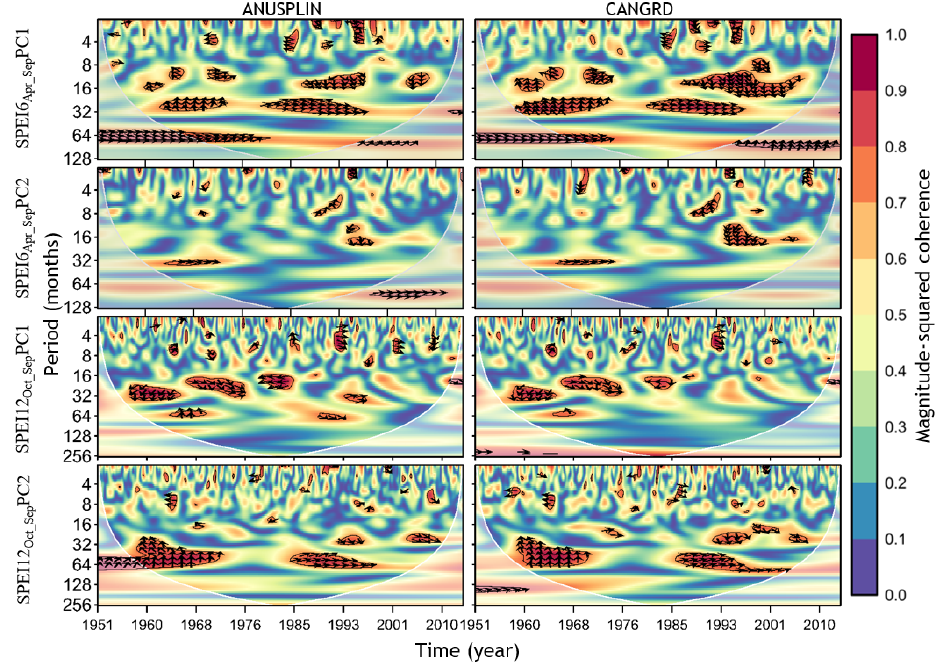
Figure 11. Squared wavelet coherence between the PNA and the temporal patterns of drought (SPEI6 Apr − Sep and SPEI12 Oct − Sep ). Phase arrows pointing right indicate signals are in phase, whereas left-pointing arrows indicate an antiphase relationship. Arrows deviating from the horizontal are indicative of lead–lag relationships between the two signals. The black contour designates the 95% confidence level against red noise, and the cone of influence (COI), where edge effects might distort the picture, is shown as a lighter grey